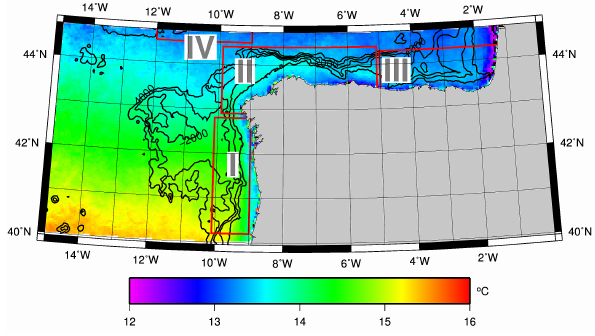
Fig. 1. The main study area with the mean December-January SST distribution. Boxes I to IV will be used to create separated ver- tical temperature and salinity datasets based on the Word Ocean Database individual casts. Area IV (12.0–9.0 ◦ W, 44.5–46.5 ◦ N) is only partially shown. The 1000 to 4000m depth contours are shown with a 1000m depth interval, and the 200 m depth contour is also